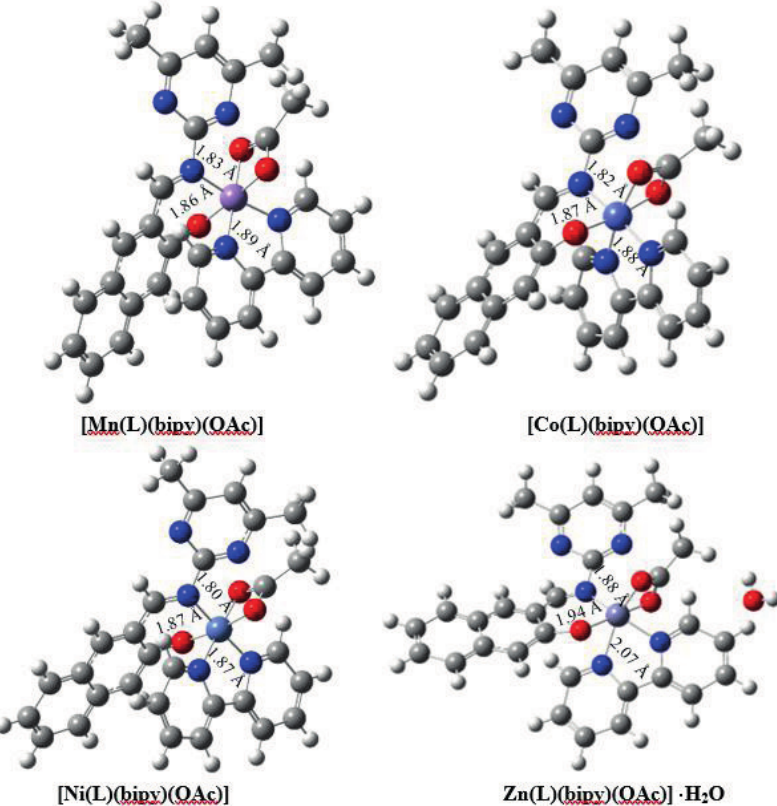
Table 2 : Thermodynamic parameters of metal complexes obtained at B3LYP/ 6-31+G(d,p) +LANL2DZ .